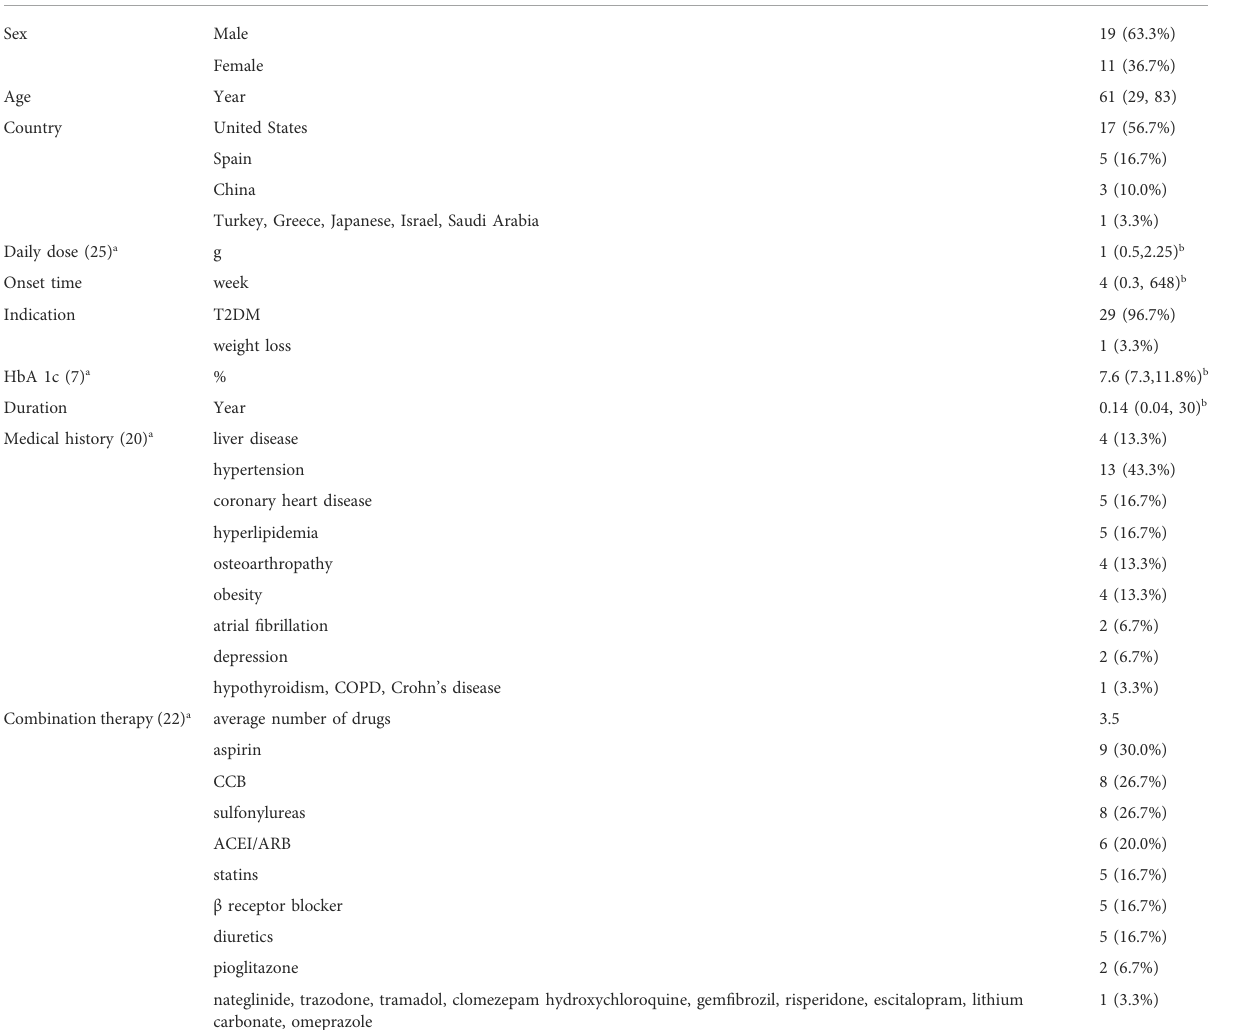
TABLE 2 Basic data of 30 patients with metformin-induced hepatotoxicity.